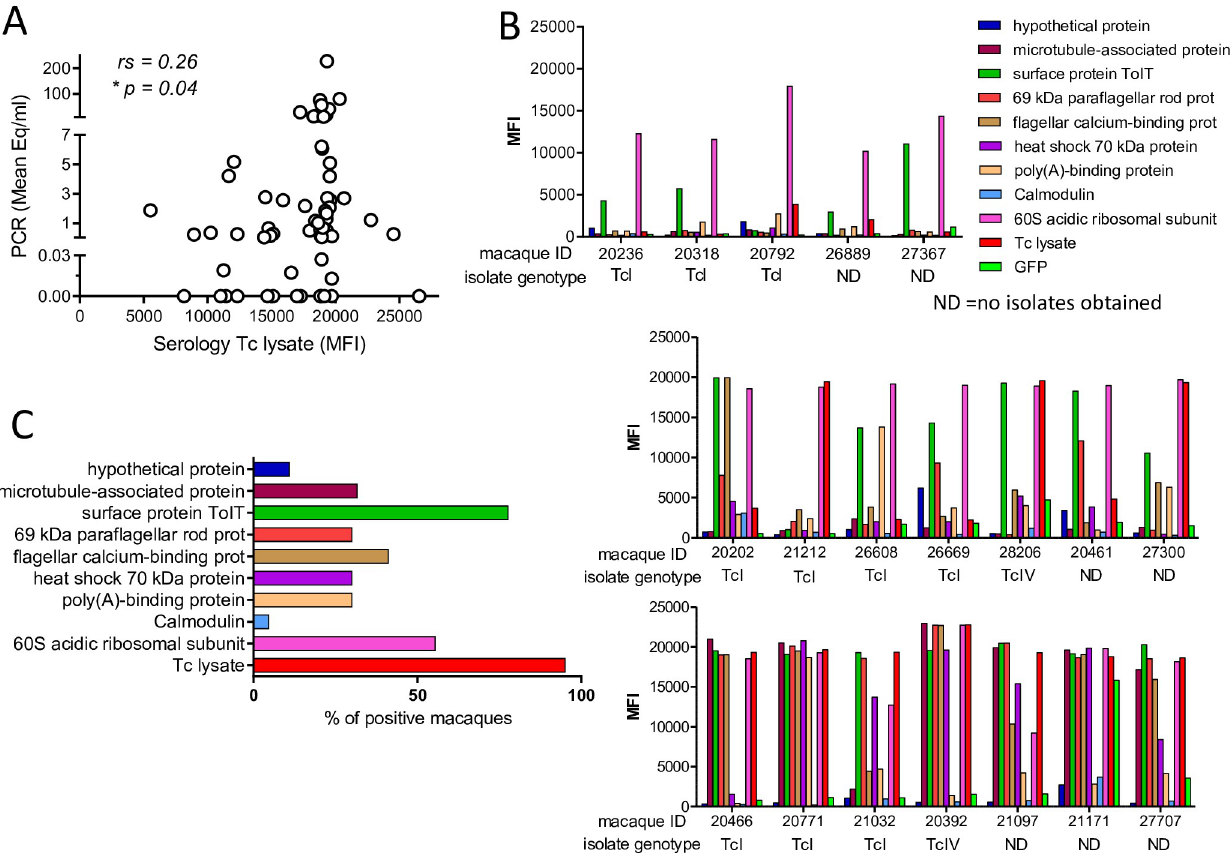
Fig 2. T . cruzi infected macaques display high levels of specific antibodies against parasite antigens. (A) Reactivity of macaque sera against T . cruzi lysate is displayed on the X-axis as median fluorescence intensity (MFI) in a multiplex assay and related on the Y-axis to mean parasite load in blood determined by serial qPCR. Each symbol represents an individual macaque (n = 64). (B) Reactivity against 9 recombinant T . cruzi proteins. Each bar represents the median fluorescence intensity (MFI) to the specific antigen. Individual macaques are referred by their identification number on the X axes and the genotype of the parasites isolated from that macaque are noted. T . cruzi lysate and green fluorescent protein (GFP) were used as positive and negative controls respectively. Graphs are representative of macaques with weak (top), intermediate (middle), and strong (bottom) reactivity against the recombinant proteins. ND: no parasites were obtained by hemoculture to allow genotyping. (C) Percentage of macaques with a median fluorescence intensity above the negative control (GFP) for each T . cruzi recombinant protein. rs: Spearman’s correlation coefficient; � p < 0.05.